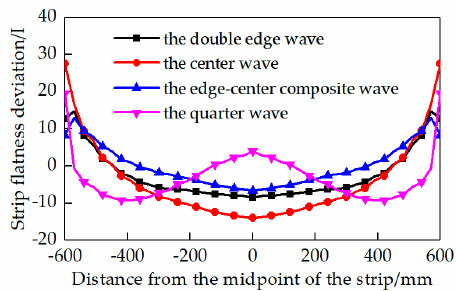
Figure 13. The effect of different flatness defects on the flatness calculation deviation. Figure 13. The e ff ect of di ff erent flatness defects on the flatness calculation